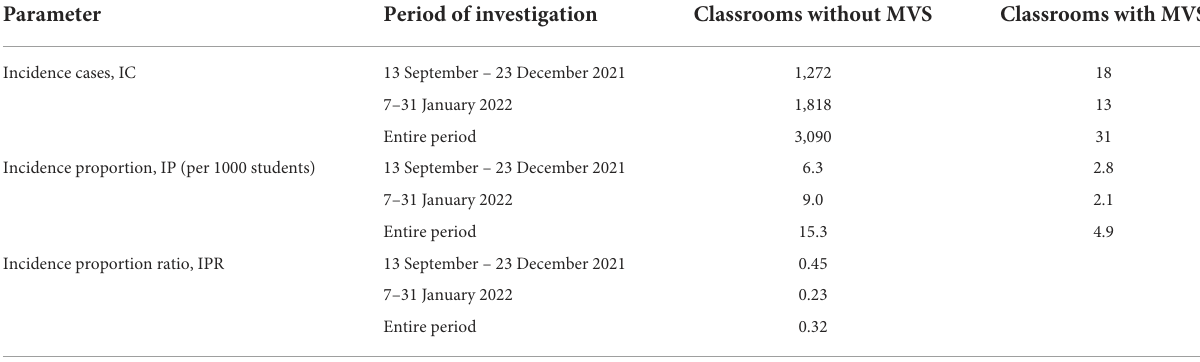
TABLE 1 Incidence cases (ICs), incidence proportions (IPs), and incidence proportion ratios (IPRs) observed in classrooms with and without mechanical ventilation systems (MVSs) during the periods of investigation.